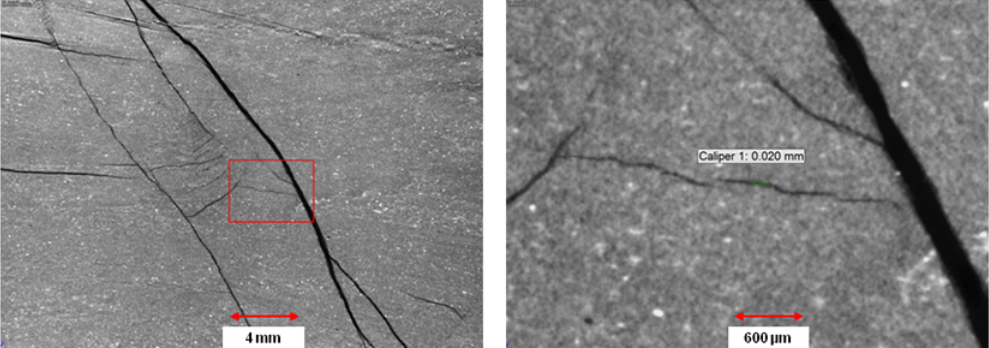
Figure 8. Many small-scale details of the mineralogical composition are now visible, as well as numerous small fractures. The red area is magnified on the right-hand side. Here, a small fracture is shown, which has an approximate aperture of about